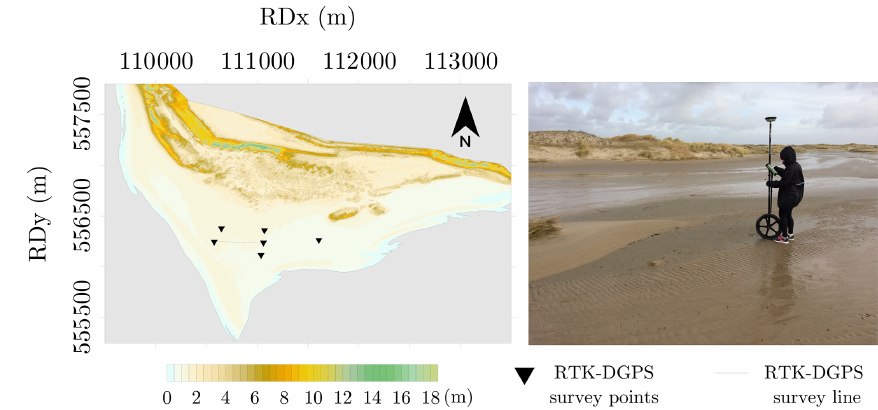
Figure 3. Location of the RTK-DGPS survey transects and